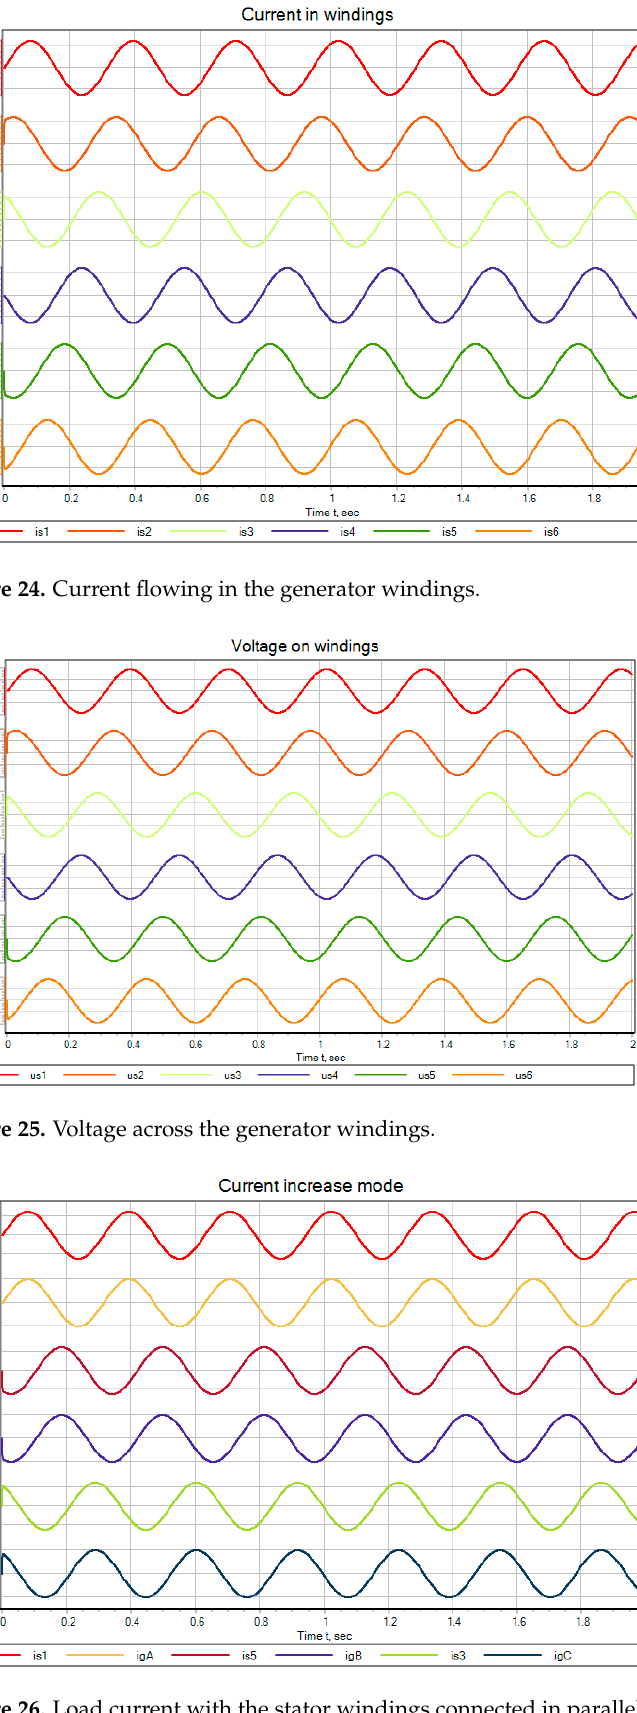
Figure 26. Load current with the stator windings connected in parallel.